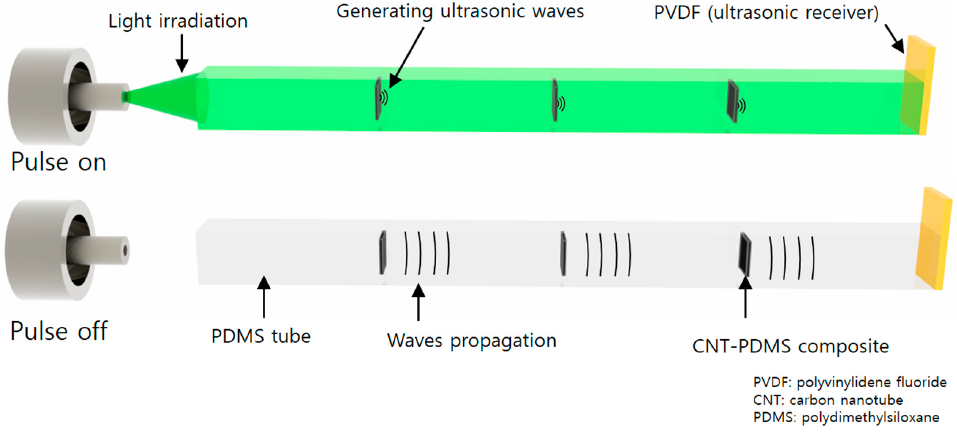
Figure 1. Operational principle of the strain sensor based on the photoacoustic effect.